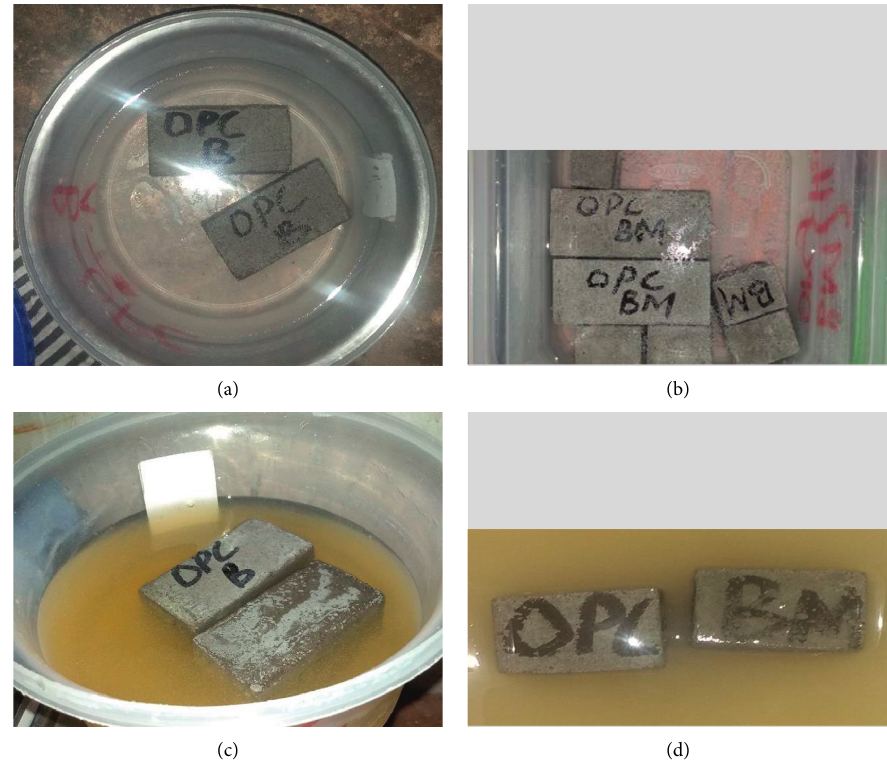
Figure 1: Cement mortar curing in varied regimes. (a) OPC-H Sample Sample cleaning stabilizing